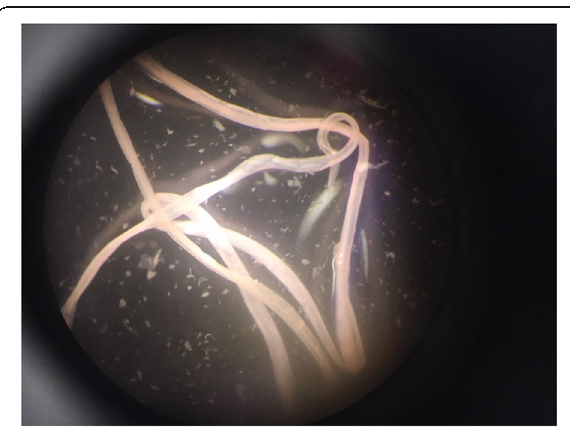
Fig. 2 The nematode placed in a vial after removal from the subconjunctival space